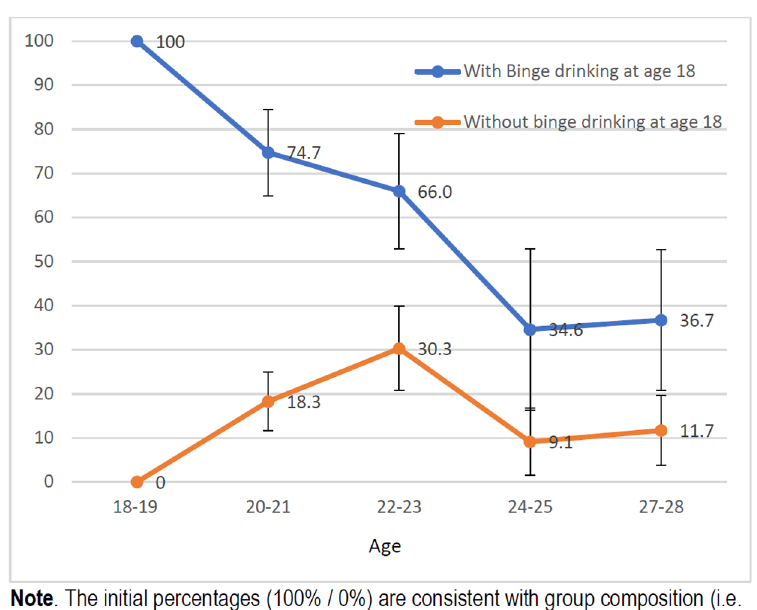
Fig 4. Trends in prevalence of binge drinking (%) among men who already partook and who did not partake in binge drinking at age 18–19.